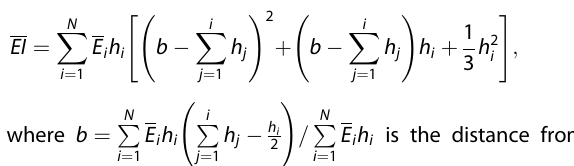
Fig. 2 3D pop-up structures formed by the mechanical assembly and their mechanical and in vitro electrical characteristics. a Schematics of the pop-up fabrication process. The top view of the left schematic shows the bonding area (red), reactive ion etching (RIE) area (gray), and non-bonding area to be part of the pop-up probe (yellow). The side view schematic shows the device transferred in a pre-stretched elastomer with the RIE-etched area. The last schematic shows the folded probe after releasing. The red rectangle inset shows a hinge design including width of 90 µm and a cutting length of 100 μ m, L2. The blue rectangle inset shows a reduction in thickness from 7.6 μ m of total device thickness ( t 1 ) to 3.2 μ m of etched hinge part thickness ( t 2 ). The green inset shows a magni fi ed view of the fully folded area at the hinge. b Proportional relationships between bending stiffness with polyimide (PI) thickness at the hinge, t 2 (black). And the red dashed line shows proportional relationships between the head diameter of the arc shape formed by the pop-up process with t 2 . c Photograph of the folded device with decreasing t 2 / t 1 ratio from 1 to 0.42, scale bar, 250 μ m (Top). The inset shows an scanning electron microscopy (SEM) image of the fully folded hinge with ~20 μ m probe thickness, scale bar, 50 μ m (Top). Finite element analysis (FEA) simulation of a gradual decrease in hinge thickness, scale bar, 250 μ m (Bottom). The inset shows a magni fi ed view of the fully folded hinge with Mises stress distributions, scale bar, 20 μ m (Bottom). d Optical image of the device after PEG coating, scale bar, 500 μ m. e Photograph of foldable and fl exible 3D neural electrodes of 0% (left) and 100% (right) vertical insertion test into 0.7% aragose gel, scale bar, 500 μ m. ( f and g , ±s.d. n = 25 samples) Electrochemical impedance spectroscopy (EIS) of magnitude (left) and phase (right) of electrodes before (blue) and after (red) Pt black coating by electroplating, inset scale bar, 10 μ m. h Electrochemical impedance magnitude and phase spectroscopy during the dissolution of